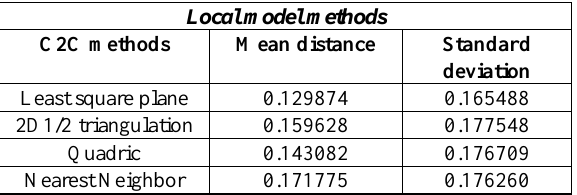
Table 9. Mean distance and standard deviation values for C2C distance computations for ICP registration method